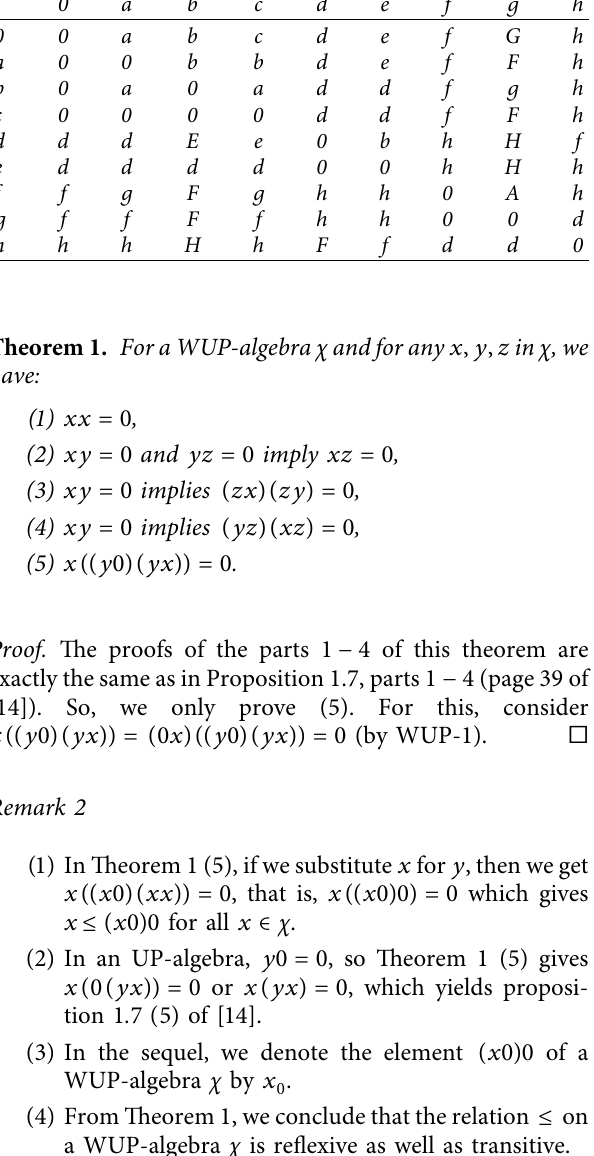
Table 3: A WUP-algebra which is not a UP-algebra.